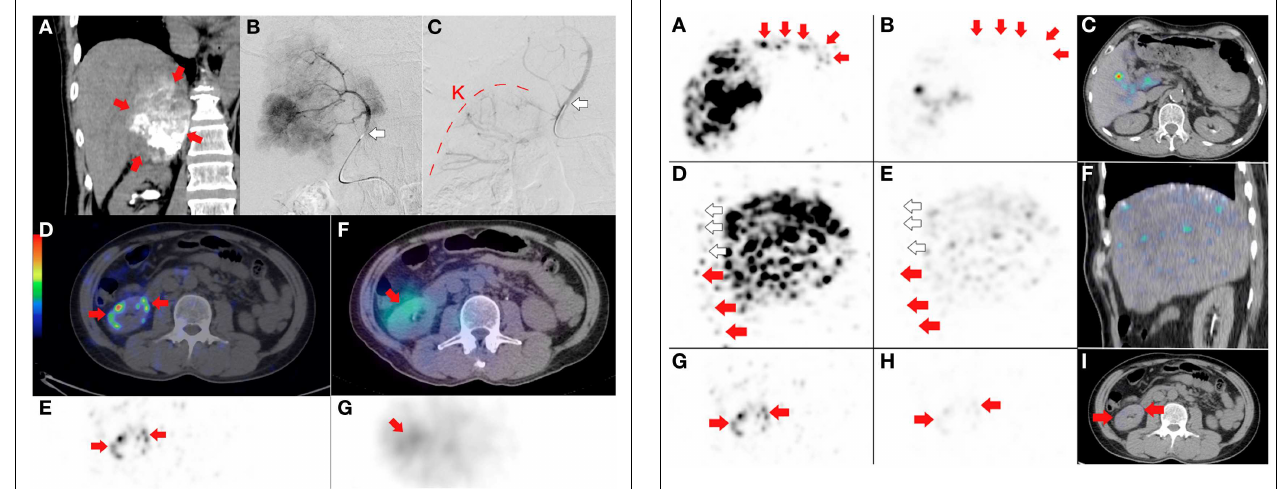
FIGURE 8 | Radioembolization to a site other than the liver . Bulky right adrenal metastasis from chemorefractory gastrointestinal stromal tumor. (A) Catheter-directed CT angiography of the right inferior adrenal artery delineates the tumor (arrows) and the target arterial territory. (B) Digital subtraction angiogram (DSA) immediately prior to microsphere injection with the catheter tip (arrow) deep within the right inferior adrenal artery demonstrates good forward flow of contrast toward the tumor. (C) Post-RE DSA with no change to catheter tip (arrow) position demonstrates significant vascular stasis and reflux of contrast down the right inferior adrenal artery and distally into the terminal branches of the right renal artery.The renal cortex (curved dashed line) of the right kidney (“K”) can be seen. (D,E) 90 Y PET/CT depicts in high resolution, non-target activity in a non-random distribution conforming to the anatomy of the right renal cortex (arrows). (F,G) 90 Y bremsstrahlung SPECT/CT shows concordant but subtle diffuse non-target activity in the right renal cortex.